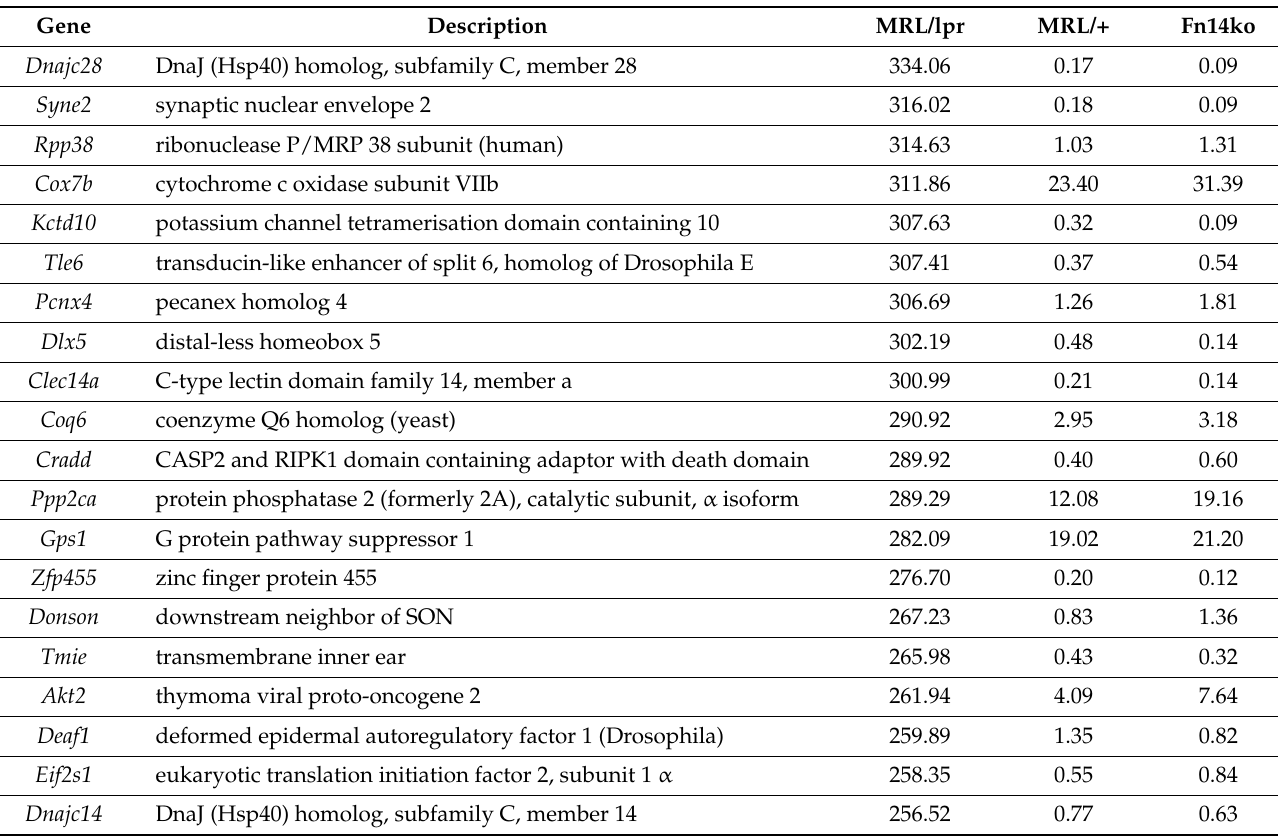
Table 1. The 20 most highly expressed genes in the hippocampus of MRL/lpr mice. Average values of gene expression (AVE) are expressed in the table as multiples of the median gene expression.